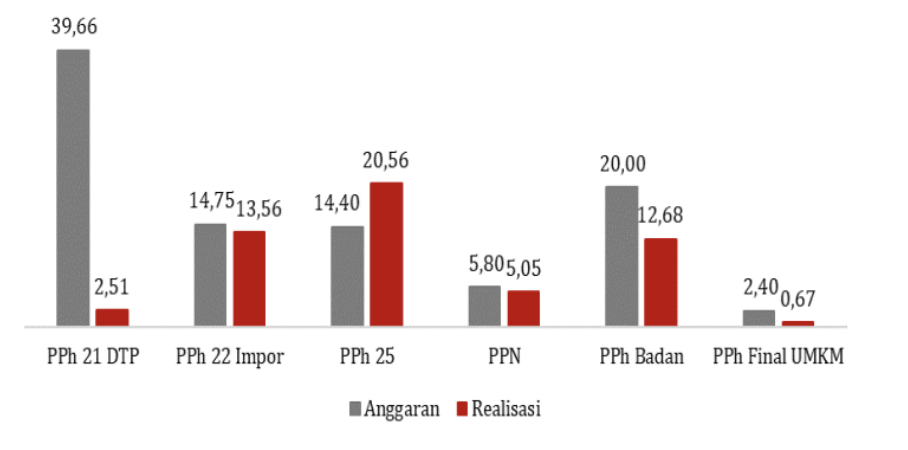
Source: Ministry of Finance,